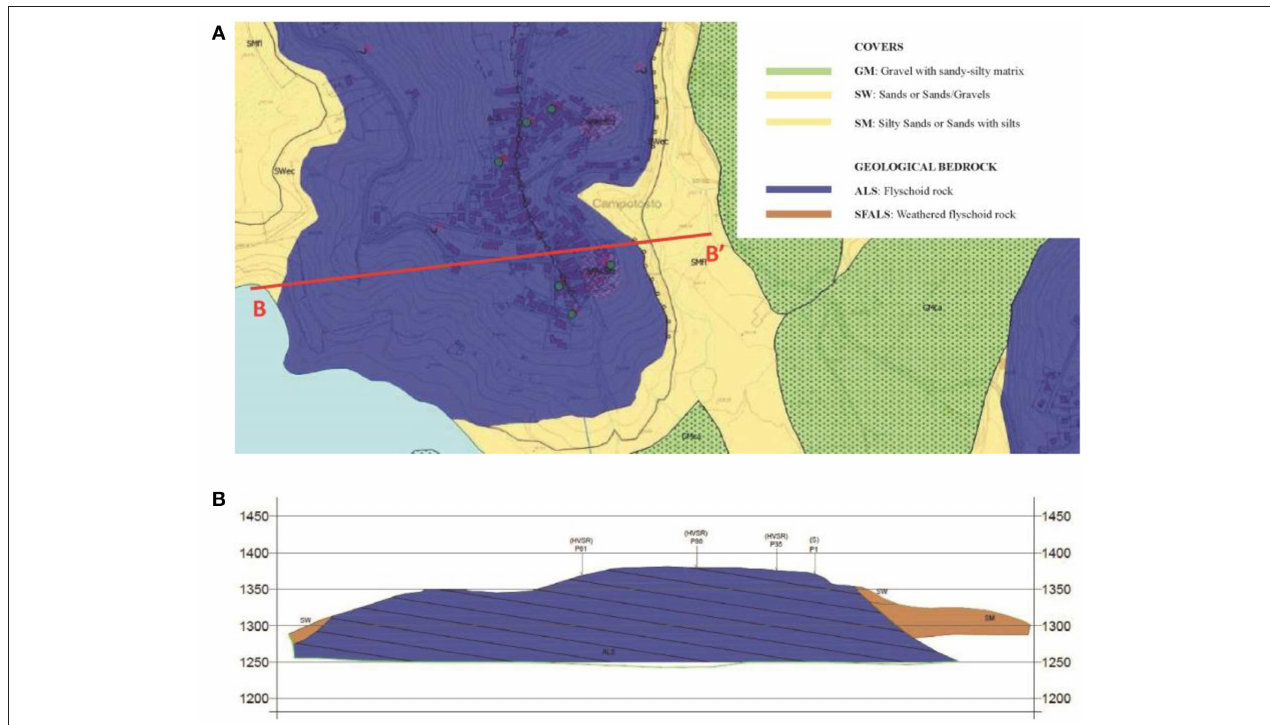
FIGURE 3 | Morphological and geological outlines: (A) Geological map of the historic center of Campotosto and (B) Geological section of the most critic area of the historic center ( D’Onofrio and Tatoni, 2017).